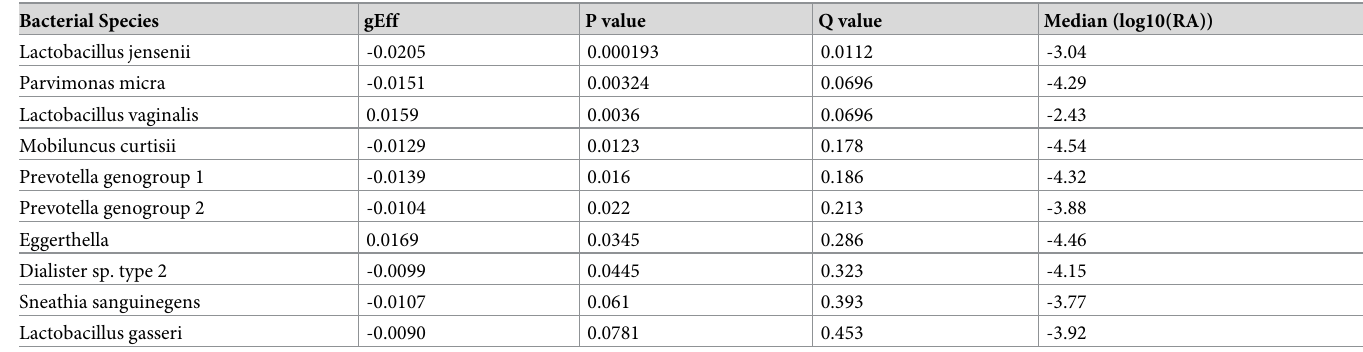
Table 4. Effect size and corresponding p and q values for associations between TFV-DP concentration in vaginal tissue and log phylotype relative abundances. Bacterial Species